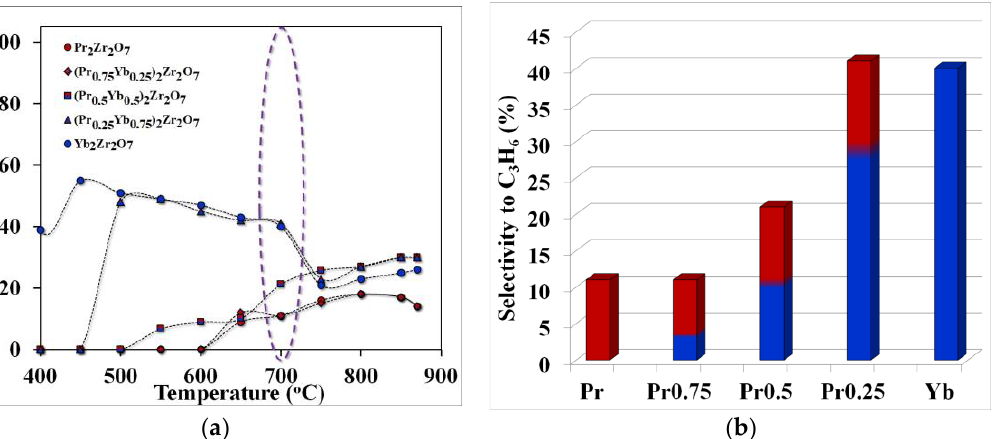
Figure 6. Temperature dependence of selectivity for propylene (purple highlights the temperature of optimal technological conditions) — ( a ), selectivity for propylene at the optimum cracking temperature — ( b ).